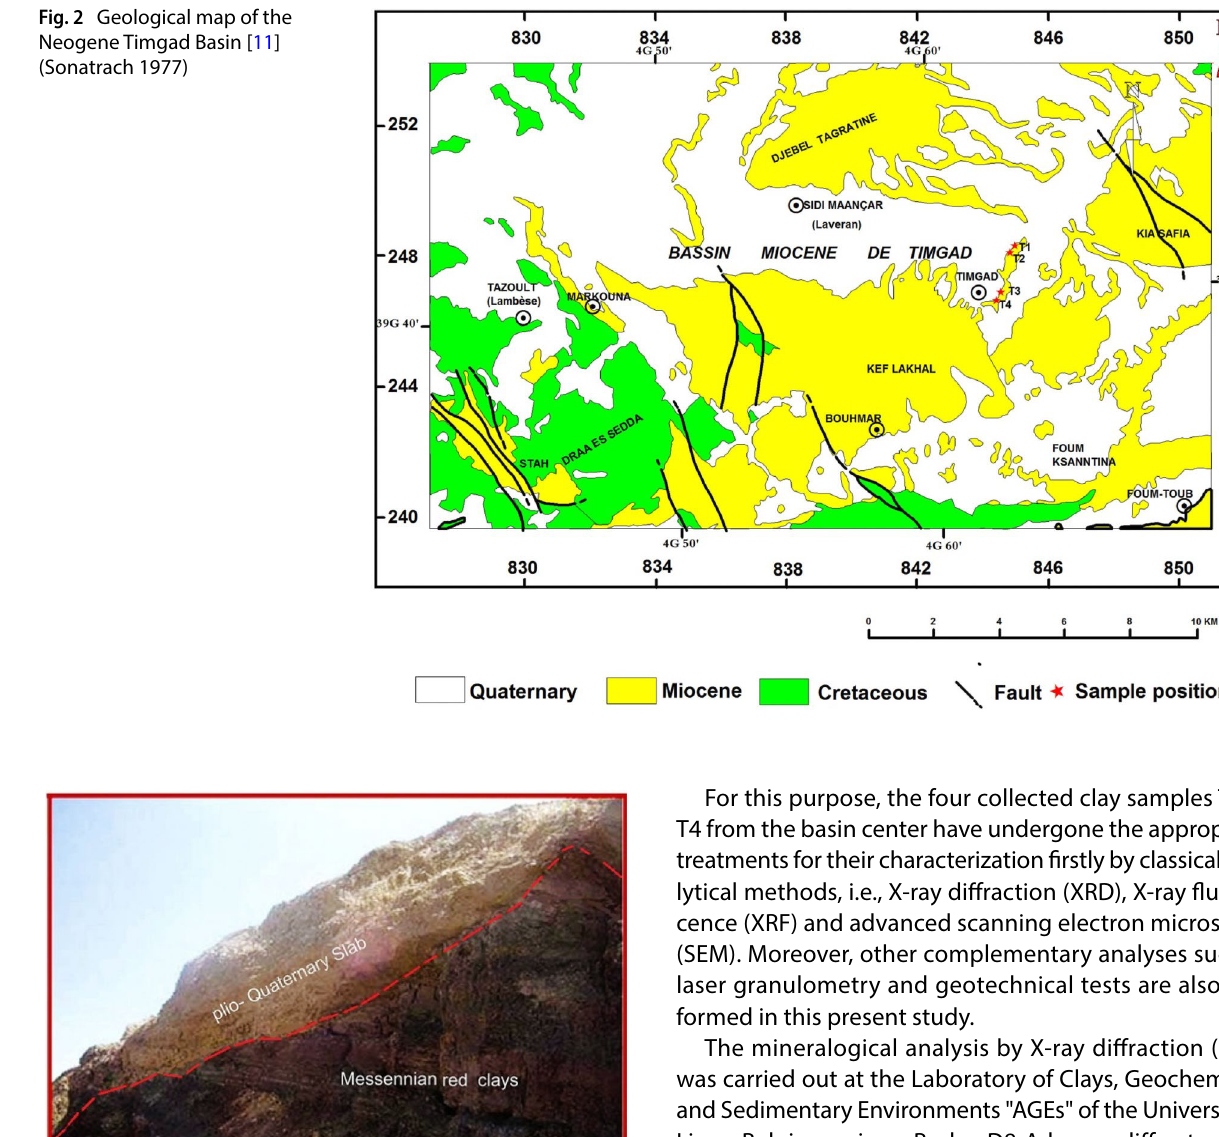
Fig. 2 Geological map of the Neogene Timgad Basin [11]